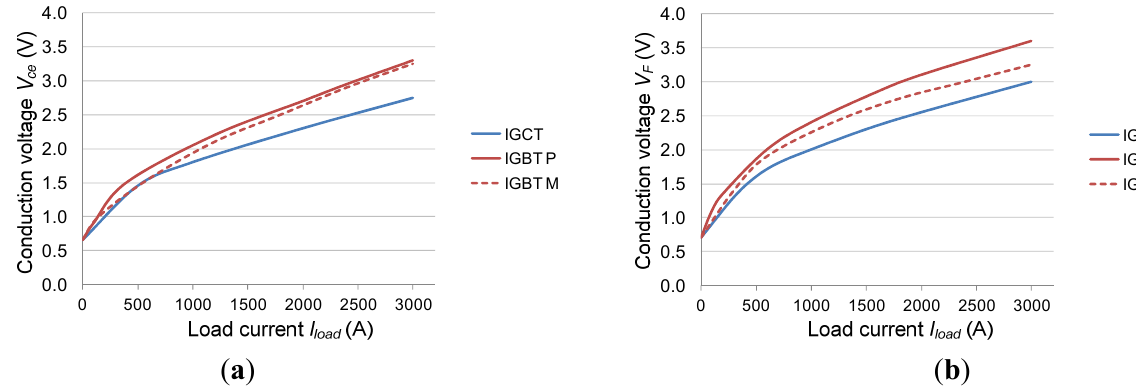
Figure 5. Normalized conduction voltage for different power devices (recommended test conditions, 125 °C). ( a ) Switches and ( b ) Diode.